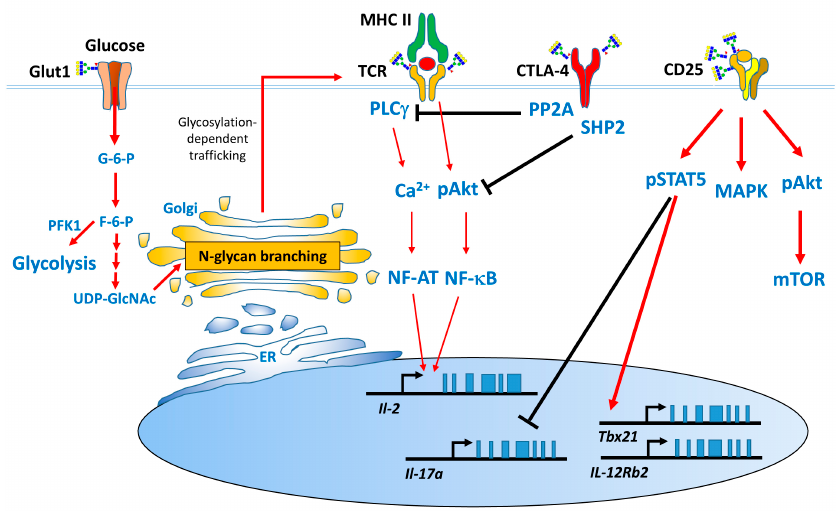
Figure 3. Metabolism, glycoprotein synthesis and T cell functions. Glucose is essential for N -glycosylation via its utilization to produce UDP-GlcNAc in the HBP. UDP-GlcNAc is used in the ER for the initiation of N -glycosylation and in the Golgi for generating N -glycan branching. TCR, CTLA-4, and CD25 are N -glycosylated. The N -glycan branching downregulates the threshold to TCR clustering and attenuates T cell activation. Moreover, the increase in CTLA-4 or CD25 surface retention present at the cell surface promotes downstream signaling and affects T cell functions. GLUT1, glucose transporter1; mTOR, mammalian target of rapamycin; PLC γ , Phospholipase C γ ; PP2A, Protein phosphatase 2; SHP-2, the SH2 domain-containing phosphatases. Acknowledgments: This work was supported by the Ministry of Science and Technology, ROC (MOST 106- 2320-B-016-009-MY3, MOST 106-2321-B-016-003, MOST 106-2321-B-016-002-MY3), Tri-Service General Hospital